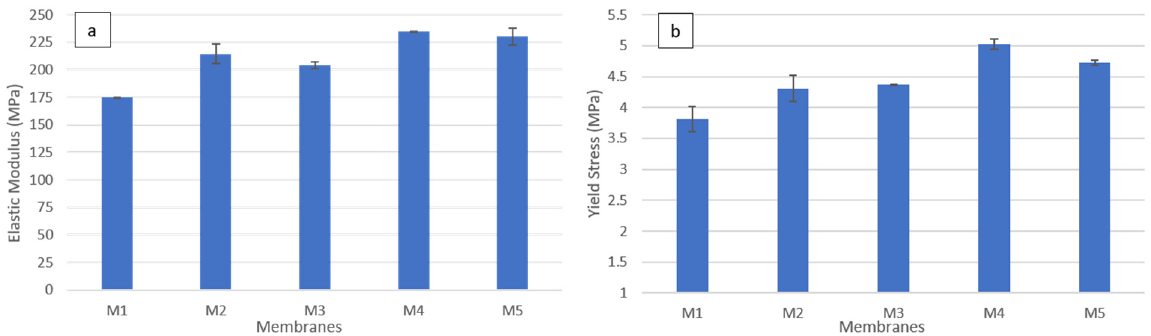
Figure 13. The mechanical properties of cast PSF membranes: ( a ) elastic modulus, ( b ) yield stress.